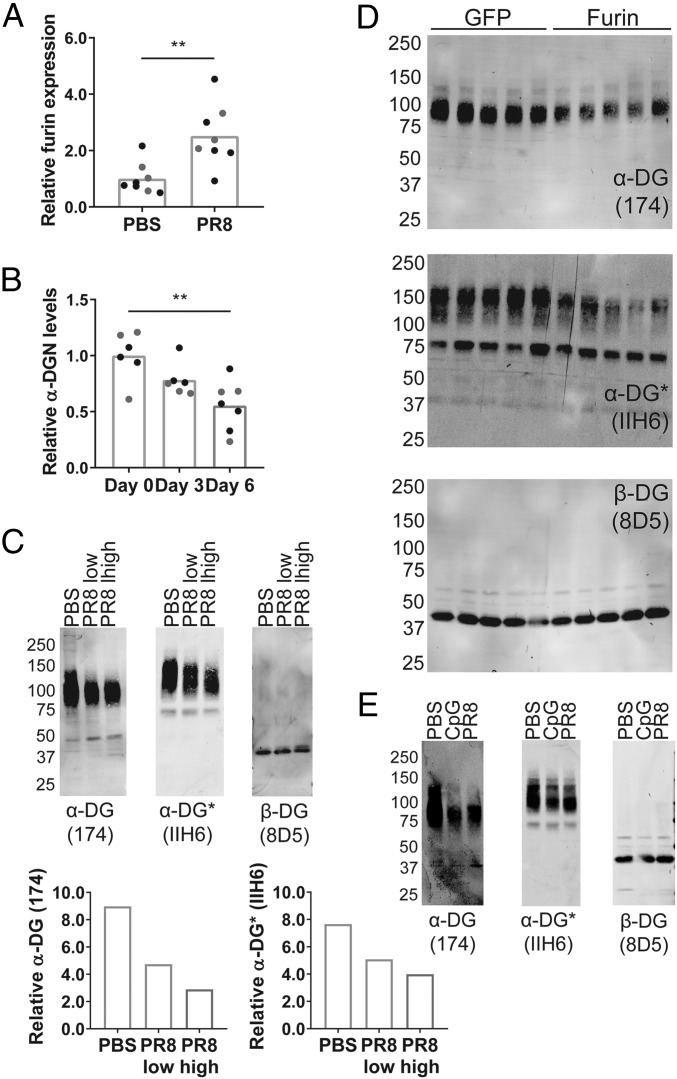
Infection with IAV elevates furin expression in the lungs and decreases α-DGN levels in the BAL fluid. (A) Furin expression in whole lung tissue of PR8-infected C57BL/6 mice 6 d after infection. Furin expression is relative to the housekeeping genes Rpl4 and Rps29 and normalized to expression in PBS-treated C57BL/6 mice, which was set at 1. Statistical analysis was performed using a Student’s t test. (B) Relative α-DGN levels in the BAL fluid of PR8-infected C57BL/6 mice at the indicated day following infection. Data are normalized to the α-DGN concentration on day 0, which was set at 1. Statistical analysis was performed using Kruskal–Wallis analysis of variance on ranks followed by Dunn’s multiple comparison tests. Data consist of two independent experiments with three to five mice (A) or three to four mice (B) per group in each experiment. Each dot represents an individual mouse; black dots represent mice in experiment 1, gray dots represent mice in experiment 2. **P < 0.01 (A and B). (C–E) α-DG protein expression, α-DG glycosylation levels, and β-DG protein expression in whole lung tissue from PR8-infected C57BL/6 mice 6 d after IAV infection (C), 2 wk after infection with an adenovirus encoding furin (D), or 1 d after intranasal treatment with CpG ODN (E). Mice received PBS, a low dose of PR8 (1 × 105 TCID50; PR8 low), or a higher dose of PR8 (2 × 105 TCID50; PR8 high). α-DG protein expression and α-DG glycosylation levels were quantified relative to β-DG protein expression (C). Mice received a control GFP-expressing adenovirus (GFP) or a furin-expressing adenovirus (Furin) (D). Mice received PBS, CpG ODN (on two occasions, 3 d apart; CpG), or PR8 (2 × 105 TCID50; PR8). Mice that received CpG ODN were killed 1 d after the second treatment; mice that received intranasal PBS or PR8 were killed on day 6 after infection (E). Data are representative of three (C) or two independent experiments (D and E). Each lane represents an individual mouse. Protein size indicated is in kilodaltons. The Sheep174 antibody binds to α-DG even in the absence of glycosylation. The IIH6 antibody detects the glycosylated form of α-DG (*). The 8D5 antibody detects β-DG (C–E).